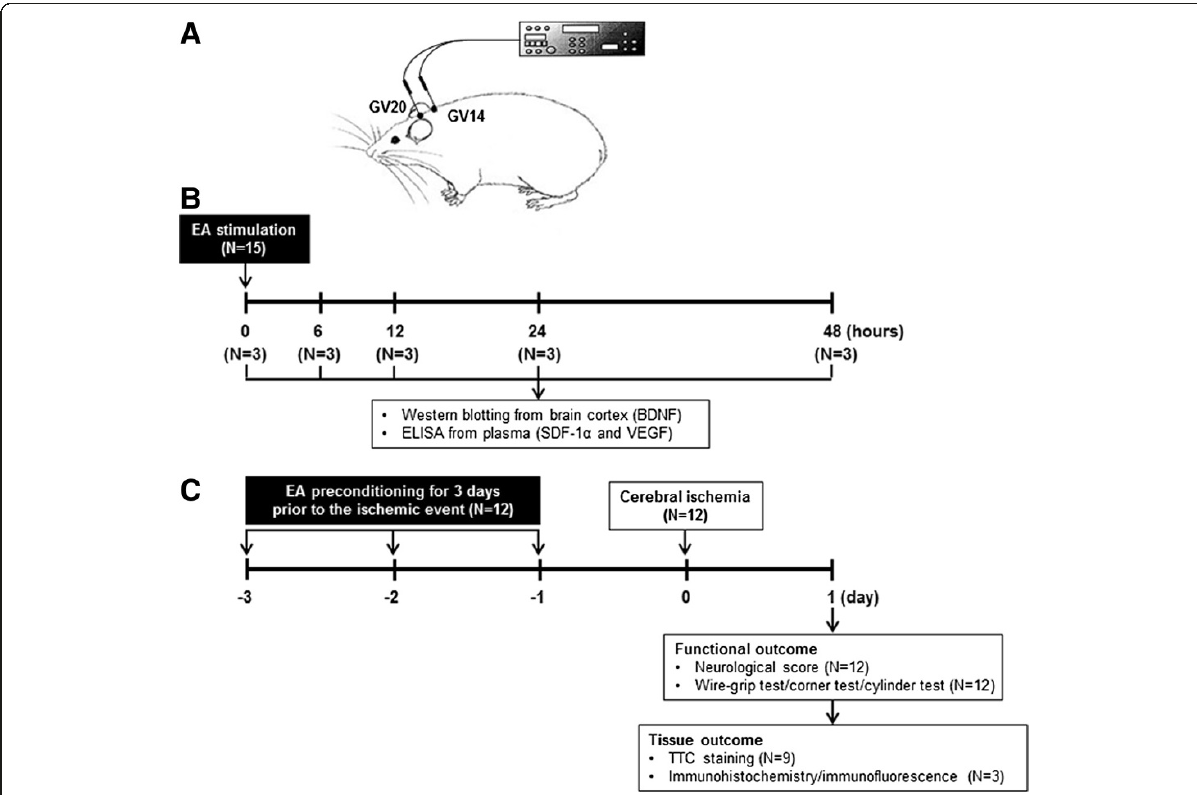
Figure 1 Summary of experimental protocols. (A) Mouse schematic showing the location of the acupuncture points used in the study. GV20 stands for ‘ Baihui ’ , which is located at the right midpoint of the parietal bone, GV14 stands for ‘ Dazhui ’ , which is located on the posterior midline and in the depression below the spinous process of the seventh cervical vertebra. (B) The time line showing the chronological events of western blotting and ELISA studies. The brain tissue and blood were collected at 6, 12, 24 and 48 h after the end of EA treatment. (C) The time line showing the chronological events of the protective effects of EA on ischemic injury. The mice received once a day 20 min EA preconditioning for three days prior to the ischemic event, then focal cerebral ischemia was induced by photothrombotic cortical ischemia. Infarct volumes, neurobehavioral deficit and motor deficit were evaluated 24 h after focal cerebral